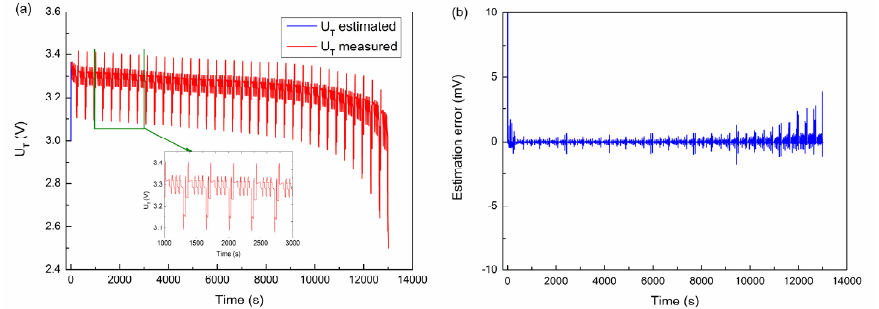
Figure 10. Validation of the identification method in the DST test at 30 °C: ( a ) the estimated voltage and measured voltage profiles and ( b ) the estimation error.